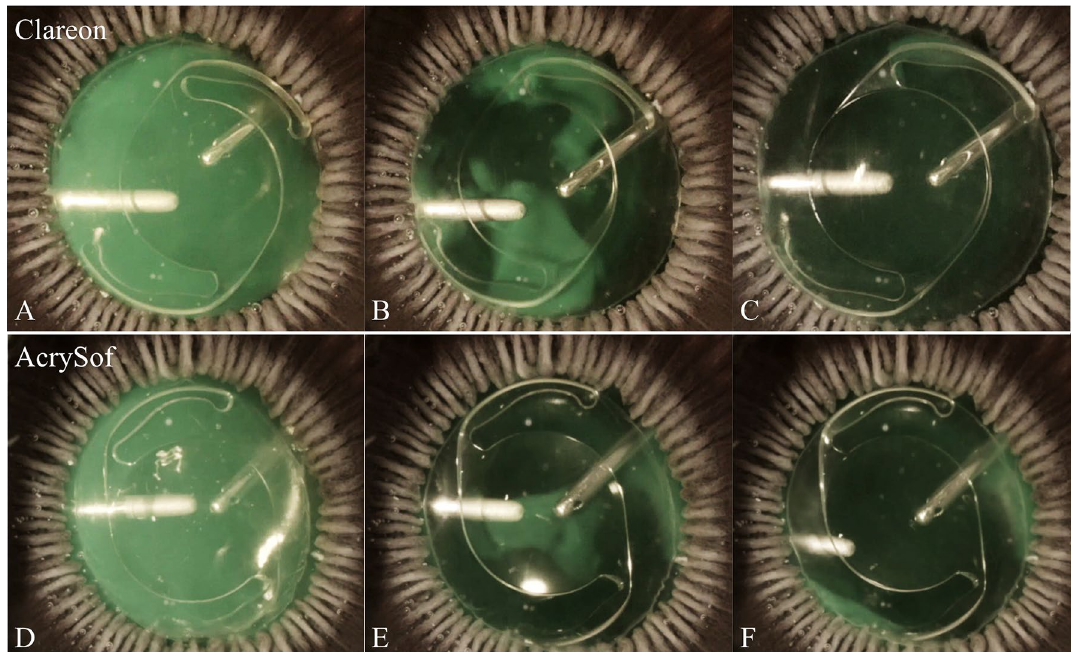
Figure 2. Course of the cohesive ophthalmic viscoelastic device (OVD) removal (Miyake-Apple posterior view) with a Clareon CNA0T0 IOL ( A – C ) and an AcrySof SN60WF IOL ( D – F ). Beginning of the irrigation/aspiration procedure ( A / D ), course of removal with some remaining OVD ( B / E ) and complete OVD removal ( C / F